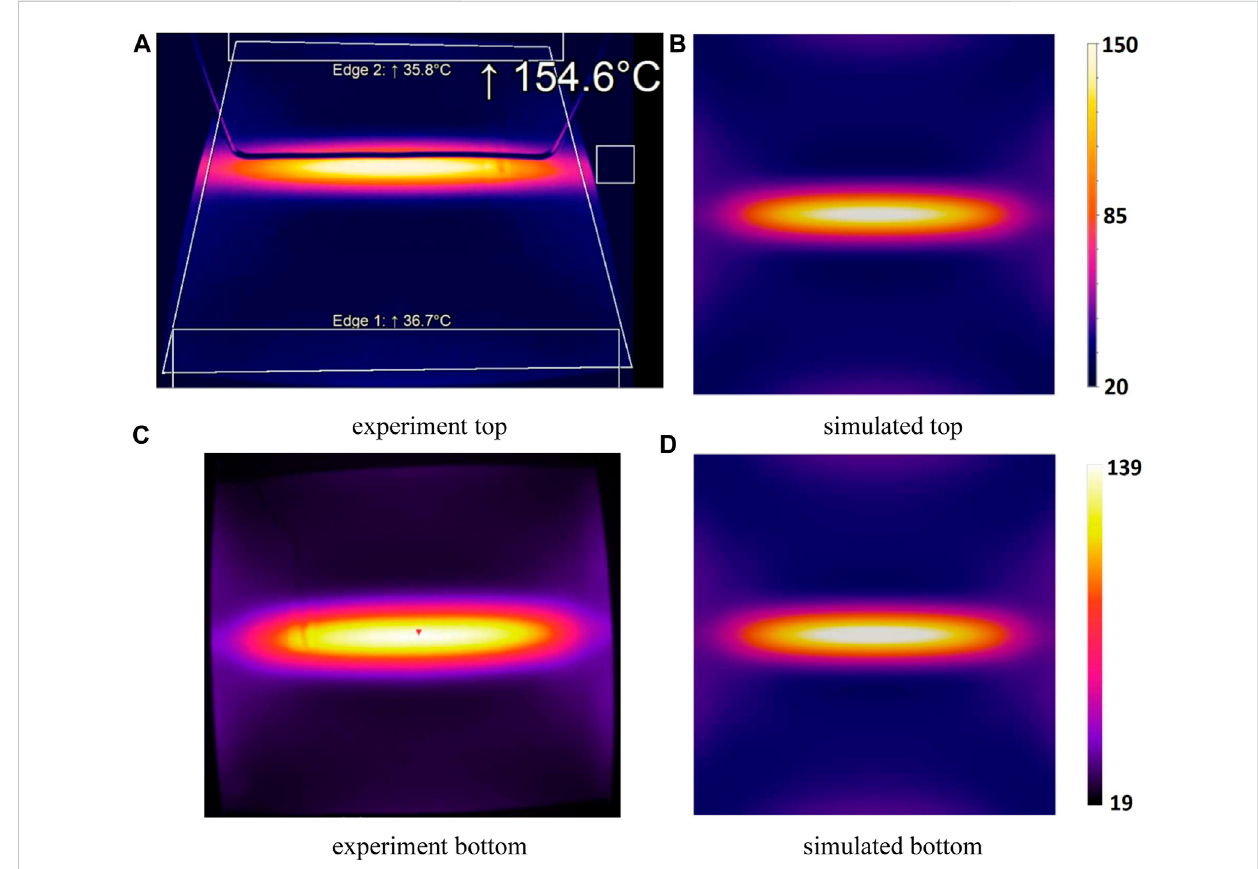
FIGURE 21 Temperature plot of top and bottom temperatures of the grouped cross-ply [0 3 ,90 3 ] 3s plate (A3). (A) and (C) correspond to measurements whereas (B) and (D) correspond to simulated